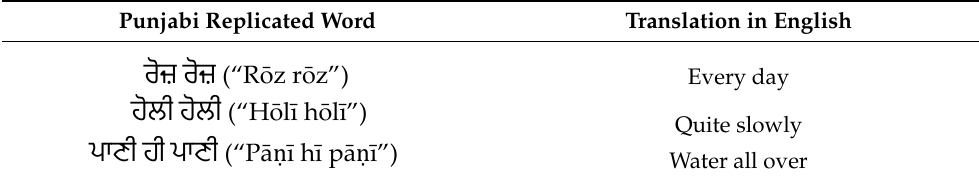
Table 2. Replicated words in Punjabi.